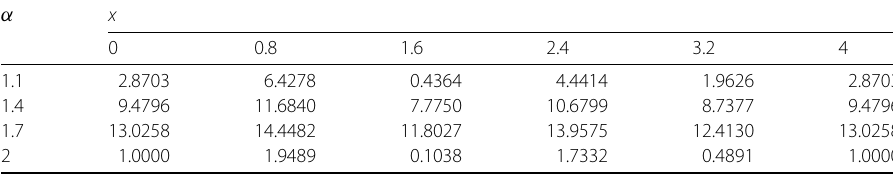
Table 4 Steady-state solutions to fractional order α ∈ (1,2] varying x ∈ [0,4] using RLFDO α x 0 0.8 1.6 2.4